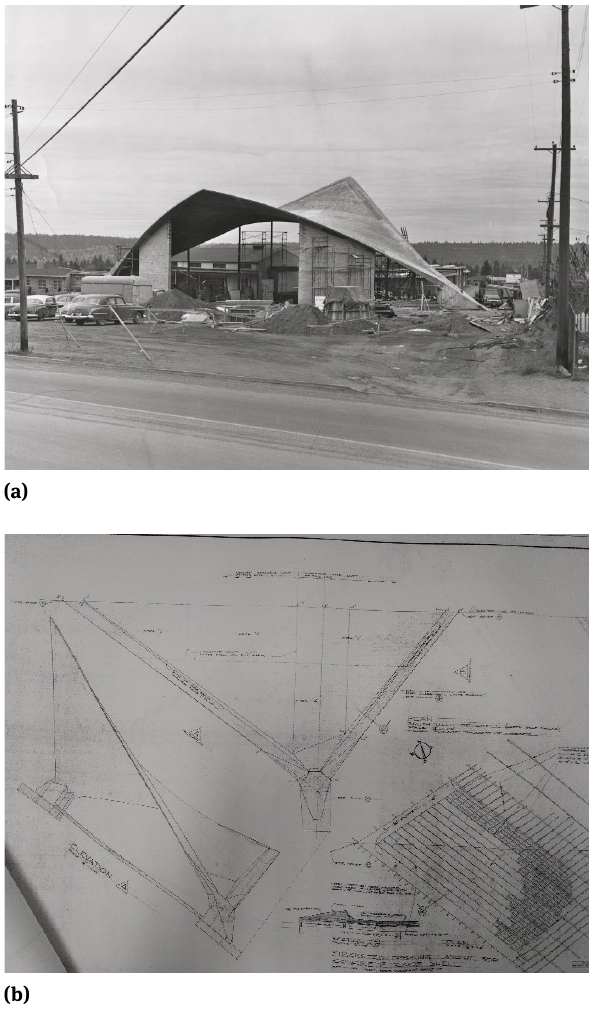
Figure 2: a) Finished shell showing 2 foundation connections and b) Isometric details of the shell